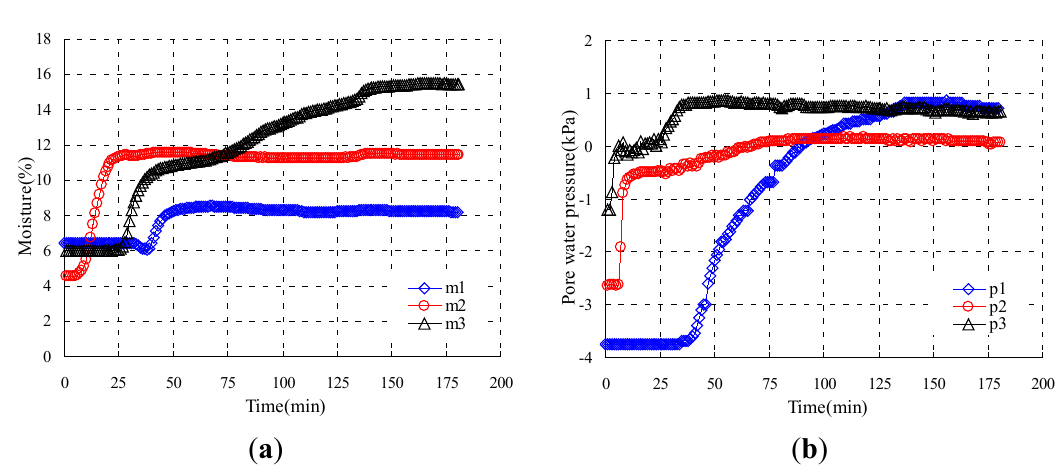
Figure 7. Soil Sample 1-25 mm/h: ( a ) Moisture content of m1, m2, and m3; and ( b ) pore water pressure of p1, p2, and p3.